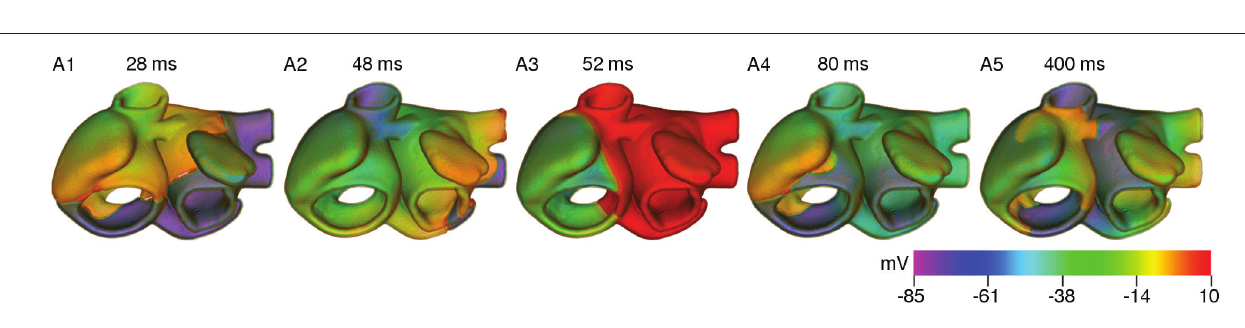
FIGURE 9 | Formation of a pair of counter-rotating scroll waves by S1-S2 cross-field protocol at 37 ◦ C under cAF-remodeled